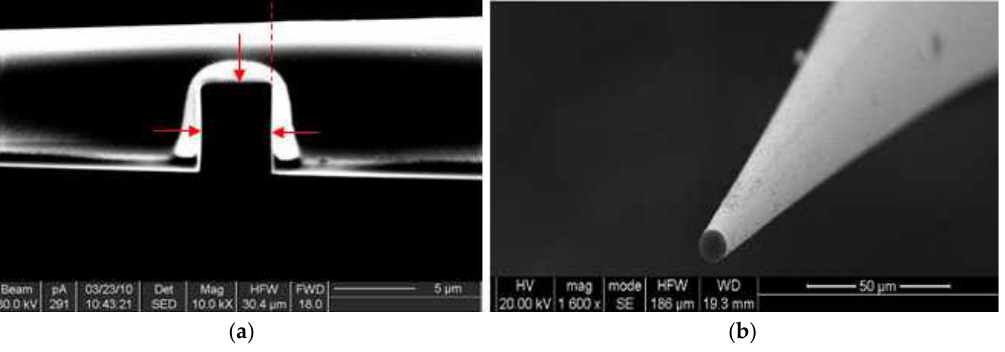
Figure 14. SEM images ( a ) of the micro-notch cavity from the side view; ( b ) of the cross section with the fiber tip cleaved at the position indicated in ( a ) by a dash line [208].